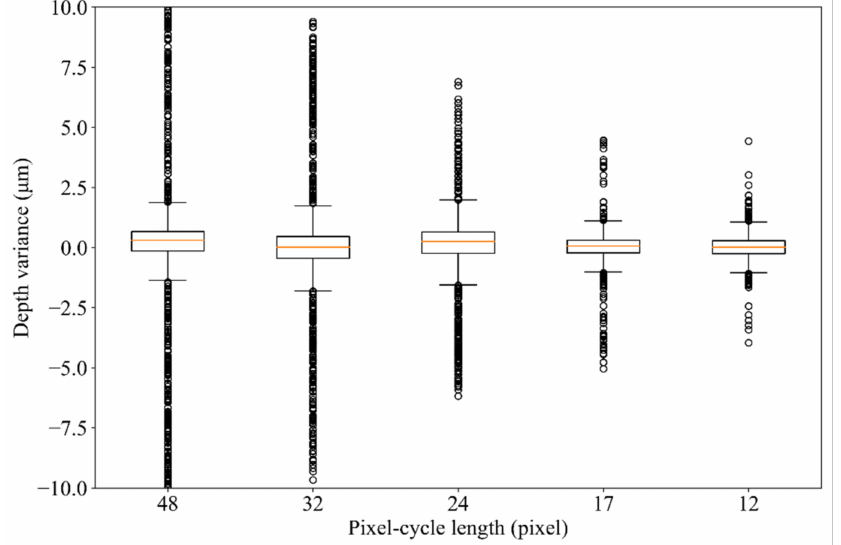
Figure 5. Results of the 3-D depth measurements by the various pixel-cycle lengths of the textures. The upper part shows the depth map of the reconstructed shape, and the lower part shows the x - z plane ( y = 600) of the reconstructed shape. Table 1. Standard errors of regression at each cycle length.